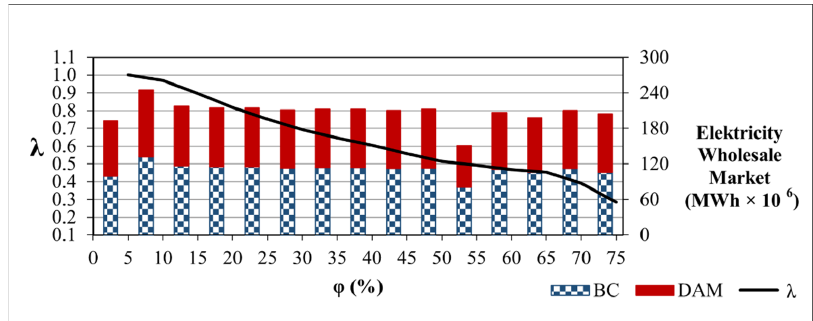
Figure 8. The relationship between φ , λ , and the electric energy wholesale market.